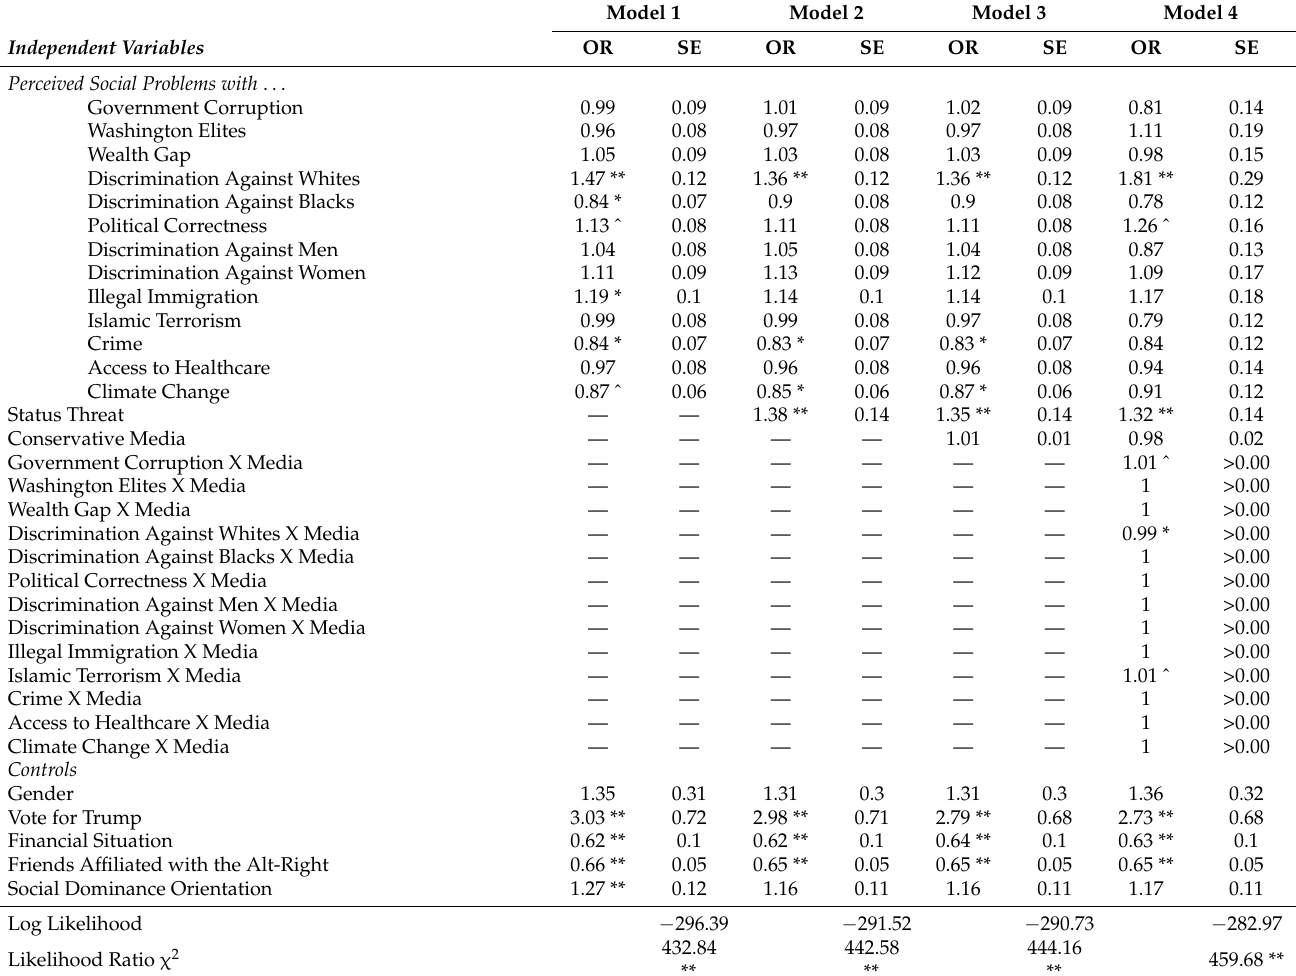
Table 3. Logistic Regression of Perceptions of Social Issues on Affiliation with the Alt-Right.